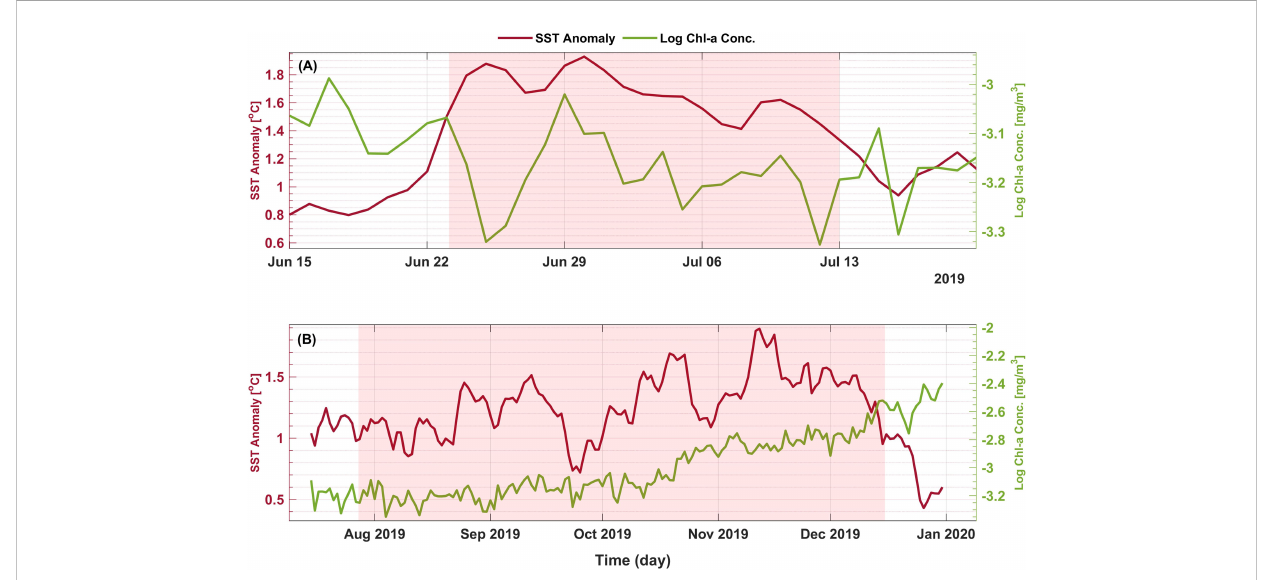
FIGURE 14 Time series of SSTA (red line) and log Chl-a concentration (green line) in the EMB during MHW events between June and December 2019. (A) shows the fi rst event and (B) shows the second event. The red shaded areas are the duration of the MHW